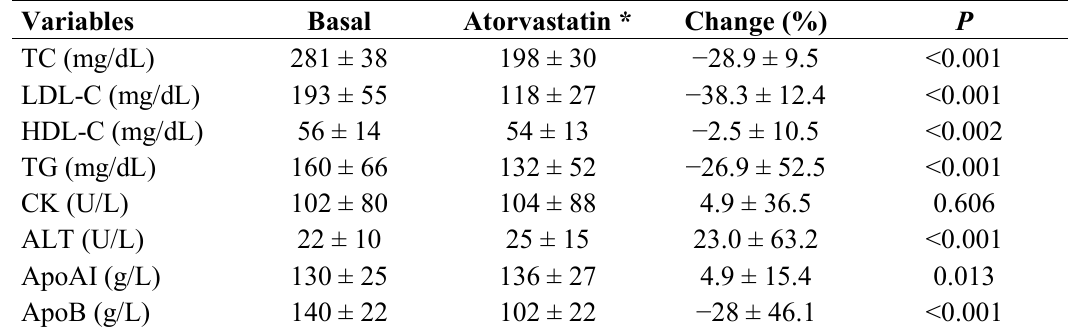
Table 1. Biochemical profile of hypercholesterolemic individuals in response to atorvastatin (10 mg/day/4